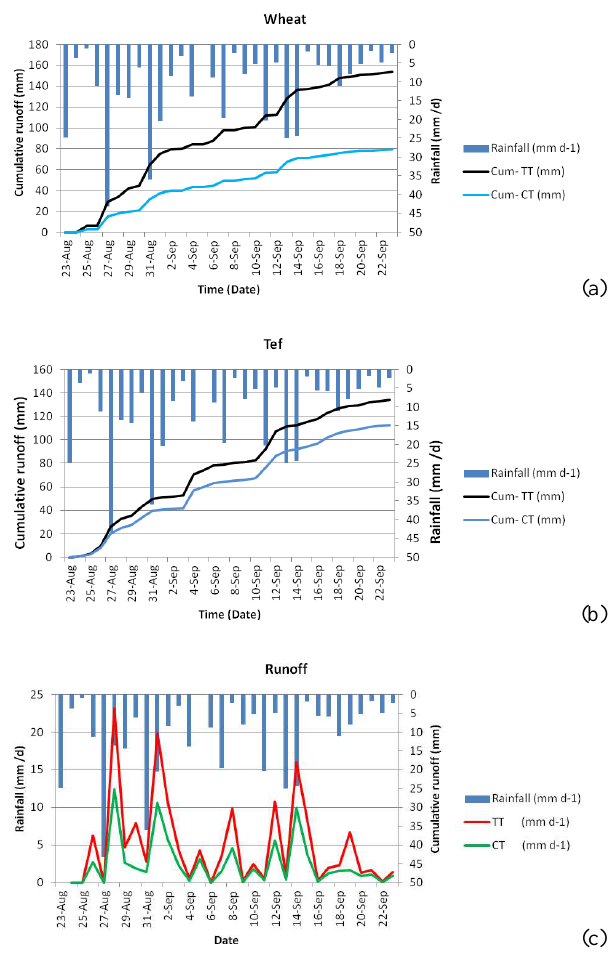
Fig. 7. Runoff in TT and CT plots of (a) wheat, (b) tef and (c) indi- vidual rainfall events and runoff in Figure 7. Runoff in TT and CT plots of (a) wheat (b) tef (c) individual rainfall events and runoff in wheat